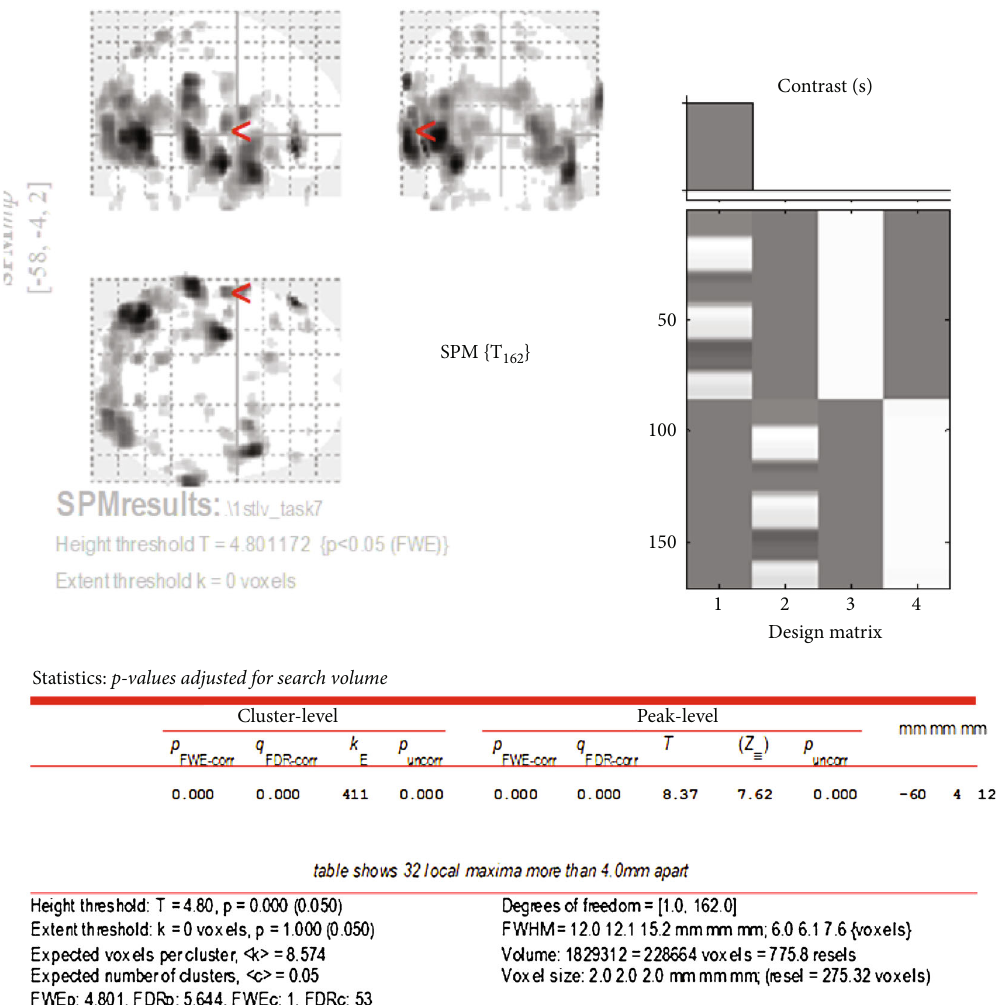
Figure 4: T value of brain activation of clenching task at initial visit.